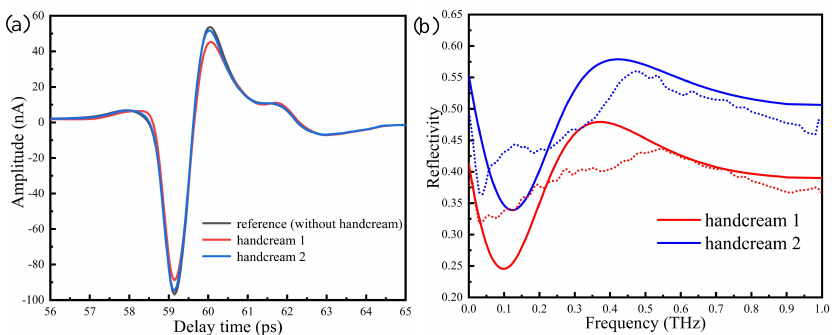
Figure 10. ( a ) The time domain spectra, ( b ) the reflection spectra. Dotted lines are experiment results and solid lines are calculated